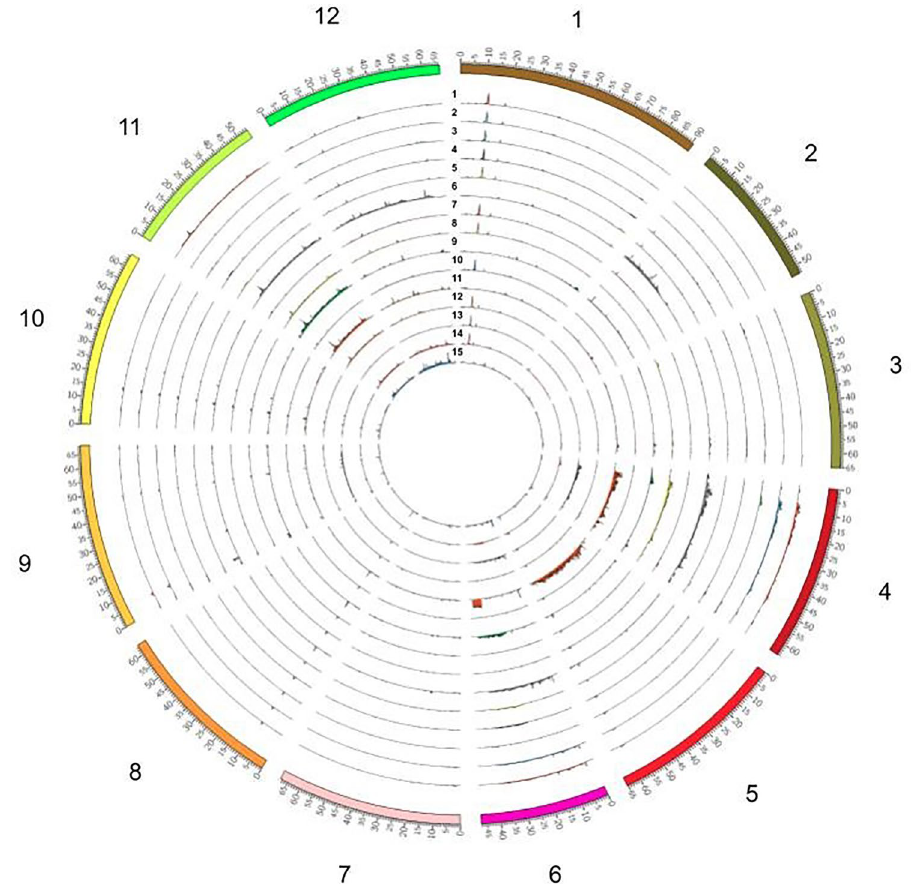
Figure 2. The distribution of SNPs across the genome for 15 bacterial wilt ( Ralstonia sp.) resistant and susceptible tomato lines. The histograms represent the number of SNPs in 100-kb for the 15 tomato accessions. The lines are numbered (1) Hawaii 7996, (2) Hawaii 7997, (3) LE415, 4) F7_80P, (5) F7_80465P, (6) LS89, (7) Bahar, (8) CRA84_115, (9) CRA84_140, (10) L390, (11) LA3501, (12) Rodade, (13) ST2, (14) T_245, and (15)